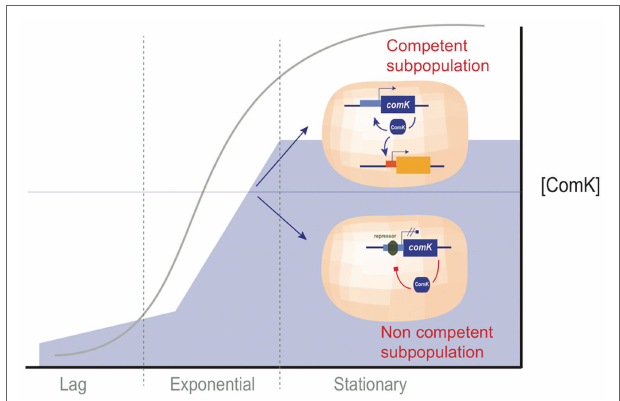
FIGURE 2 | Acquisition of competence by a Bacillus subtilis subpopulation. The fate of individual cells is decided at a critical moment in which ComK levels are intermediate and noisy. Above a threshold level, ComK drives the bacterial cell toward competence. Below the threshold level, repressors prevent ComK synthesis, and the cell does not become competent. Under laboratory conditions, the decision is taken when the culture enters stationary